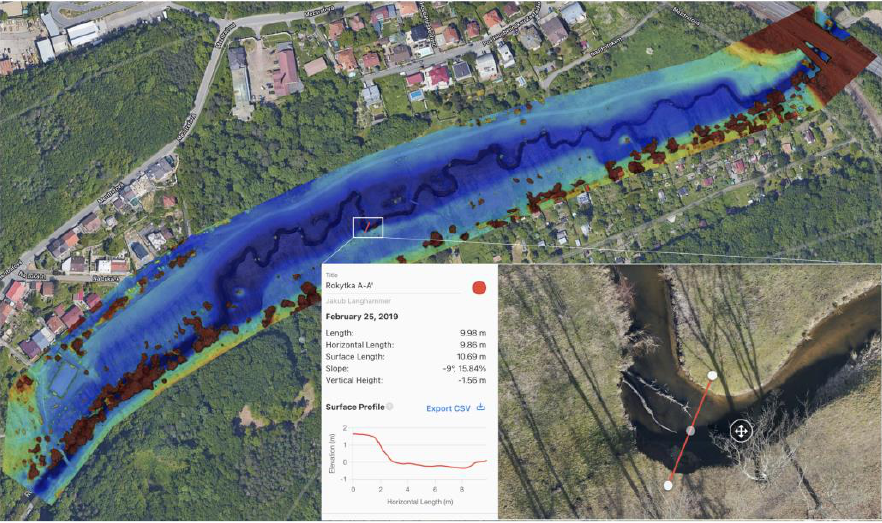
Figure 3. Interactive exploration of a cross-section for assessing channel variability, employing a 3D model from UAV imagery in DroneDeploy software. Rokytka brook, 2020, imagery: J. Langham-